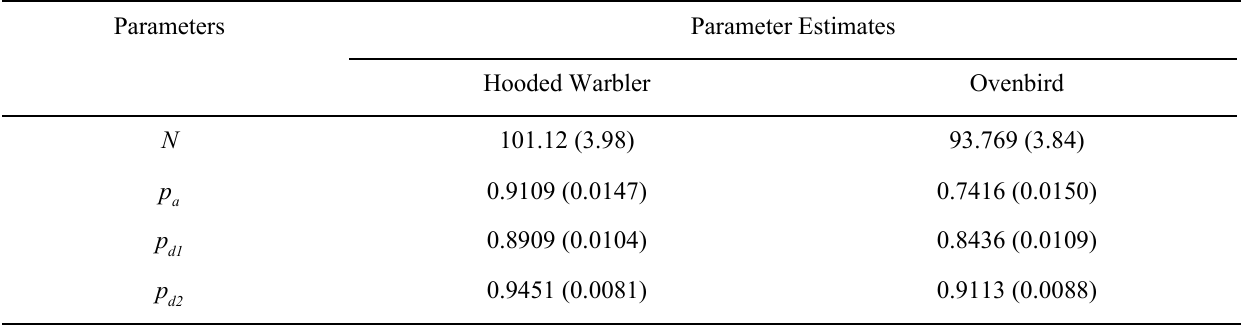
Table 2. A comparison of the Hooded Warbler and Ovenbird parameter estimates (standard errors) for a random singing model – constant random temporary emigration model, with observer dependent detection probabilities constant over time intervals. The population of birds that sing at least once in eight minutes is N = 100. Estimates and standard errors found with B = 500 bootstrap